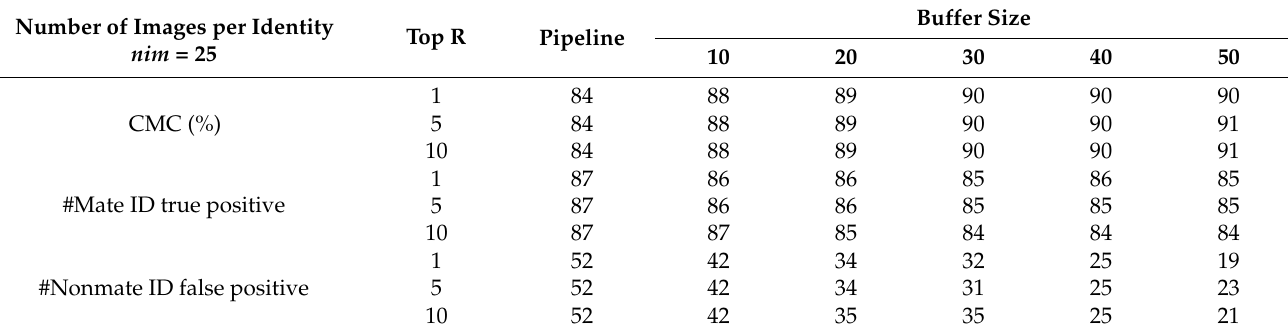
Table 3. Comparing effect of buffer size on performance on video